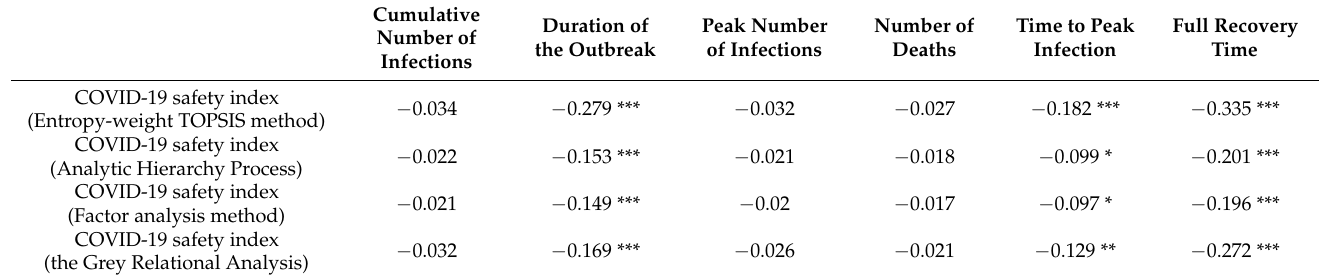
Table A1. A correlation analysis of COVID-19 safety index (calculated separately for each weight assignment method) and outbreak control performance